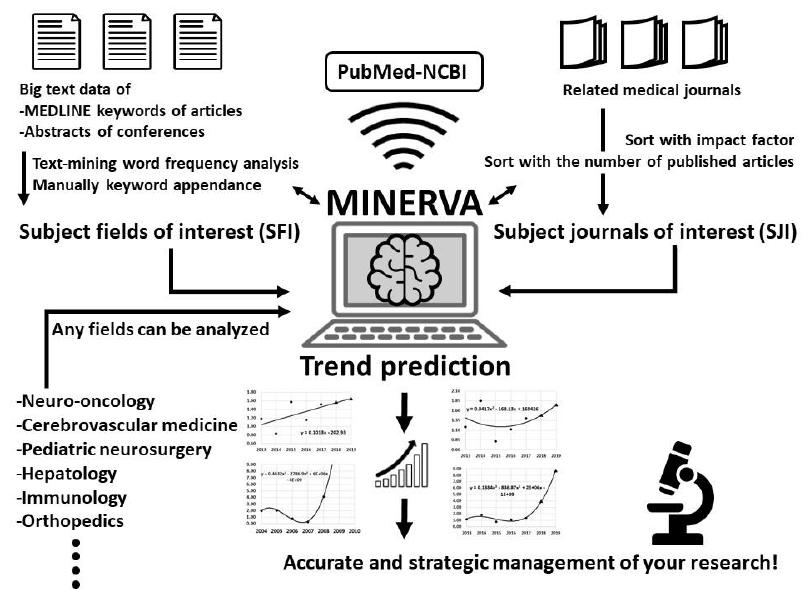
Figure 1. Conceptual diagram of Mining Integrated Navigation and Estimation Research Via Articles (MINERVA) algorithm. Based on the input data of subject fields of interest (SFI) and subject journals of interest (SJI), MINERVA will analyze the trends using PubMed database. By switching the input keywords, MINERVA can analyze the trends of any medical field.